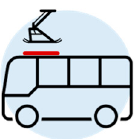
Table 5. SWOT analysis of Traditional pantograph or panto-up.